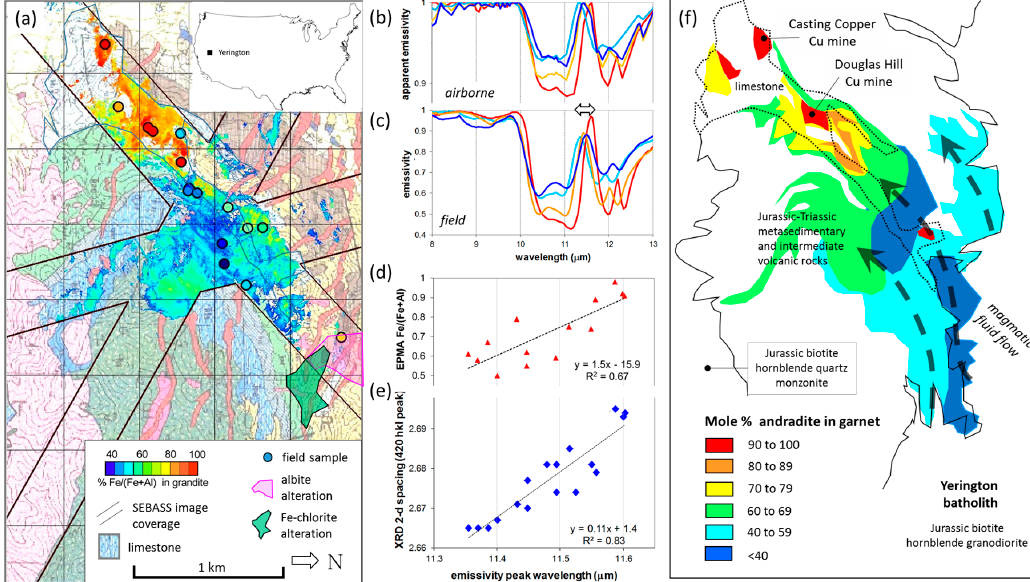
Figure 8. Garnet composition results for the Yerington copper porphyry–skarn system, Nevada, USA. Approximate scene center − 38.9544° latitude − 119.2669° longitude. ( a ) Airborne SEBASS TIR image of garnet Fe–Al chemistry based on the wavelength of the 10,600 nm emissivity peak. Similarly processed field validation data; ( b ) Selected SEBASS pixel spectra showing evidence of Ca-rich garnets (grandite); ( c ) Selected field MicroFTIR™ spectra of grandite-rich rocks from ( a ); ( d ) Scatter-grams of laboratory electron-microprobe (Fe–Al) analyses and ( e ) XRD 2D spacing of the garnet 420 hkl peak versus the MicroFTIR 10.6 µm peak wavelength position of field samples ranging in composition from andradite to grossular garnets sampled from ( a ); ( f ) Map of the andradite component (Fe) of the garnet composition based on published electron-microprobe analyses of field samples [98].